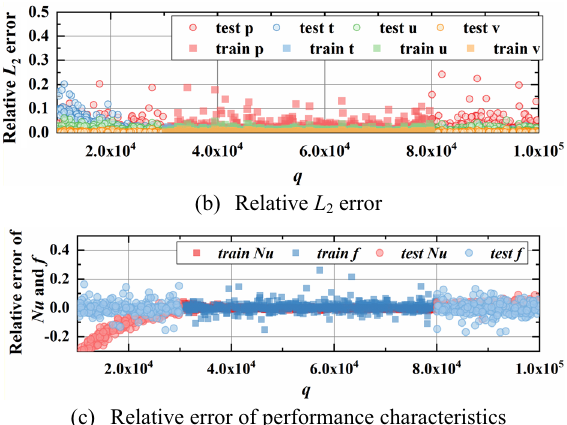
Figure 13. Extrapolation performance of